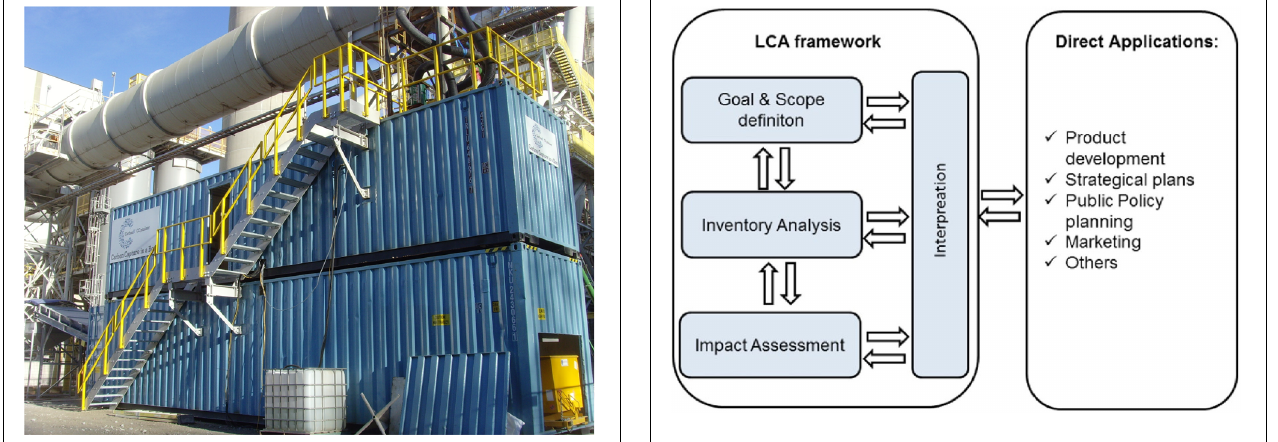
FIGURE 4 | Mobile plant for manufacture of carbonated aggregates (courtesy of Carbon8 Systems, Ltd).